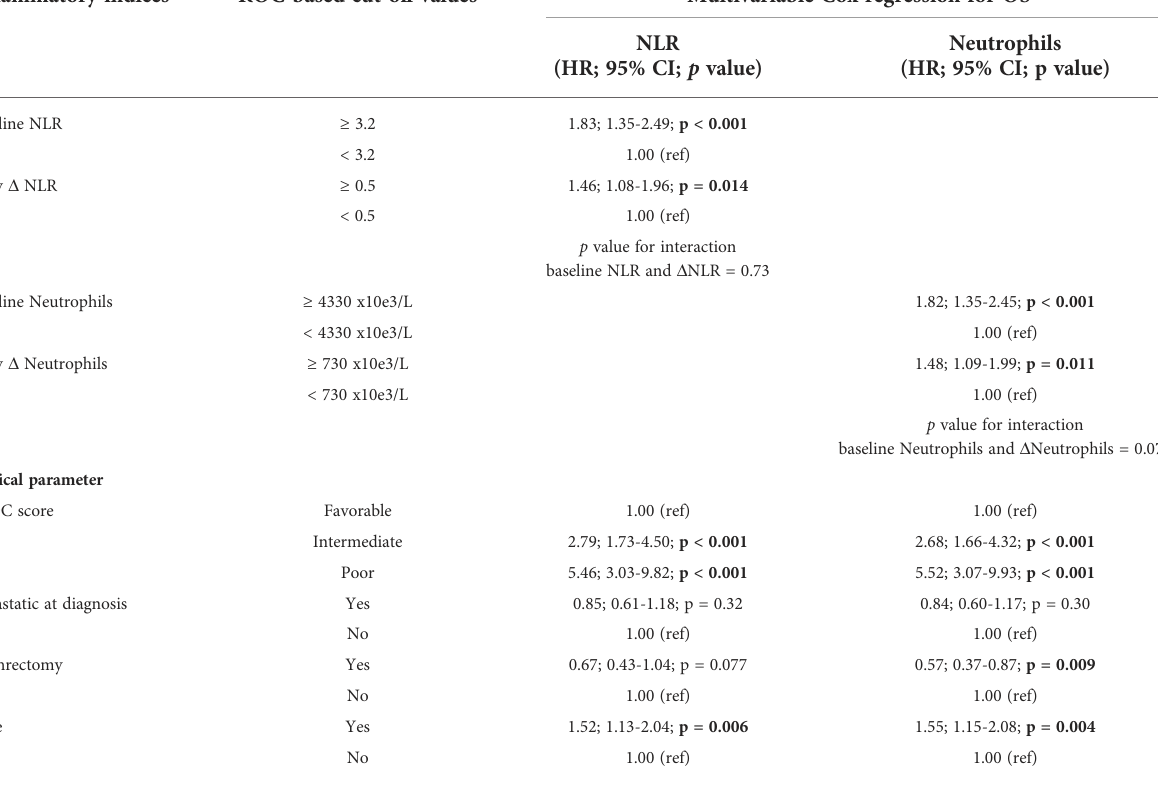
TABLE 3 Multivariable analysis on OS of absolute cell counts and immune-in fl ammatory indices baseline and early D , and baseline clinical parameters. In fl ammatory indices